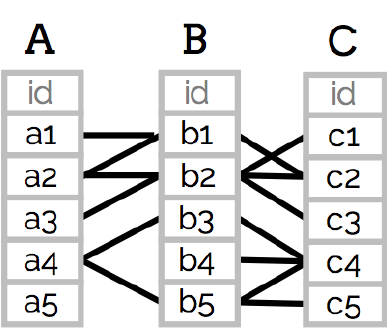
Figure 1. In Wander Join, JOIN s are modeled as a graph, and random walks are taken along valid paths to select a